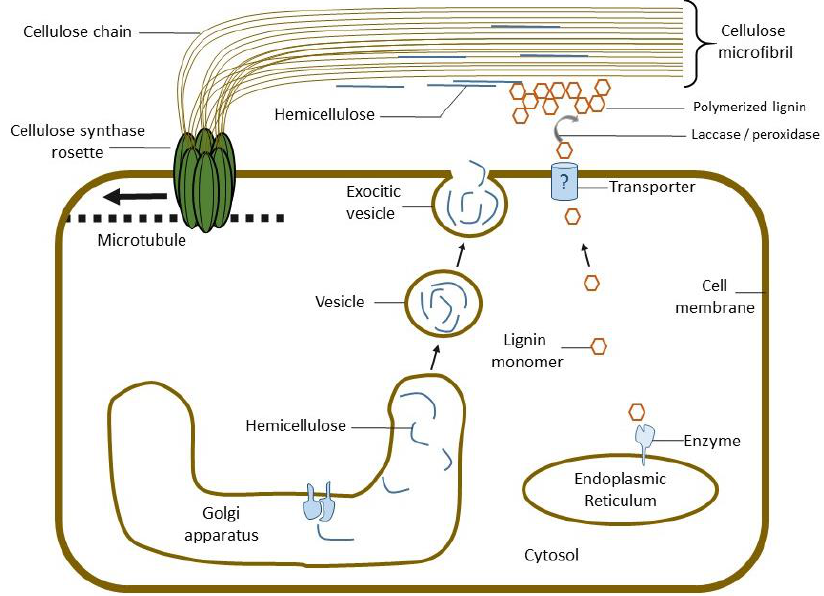
Figure 7. Deposition of cellulose, hemicellulose and lignin in the cell wall. The rosette is a protein complex in the cell membrane producing the cellulose microfibrils. The rosette moves along the microtubules. Hemicelluloses are synthesised in the Golgi apparatus and transported towards the cell wall via vesicles. Hemicelluloses are adsorbed onto the cellulose or other hemicelluloses. Lignin monomers are transported through the cell membrane via an unknown mechanism (probably a membrane transporter). The monomers polymerise together; this process might be due to the actions of laccase and peroxidase enzymes or be a random phenomenon.